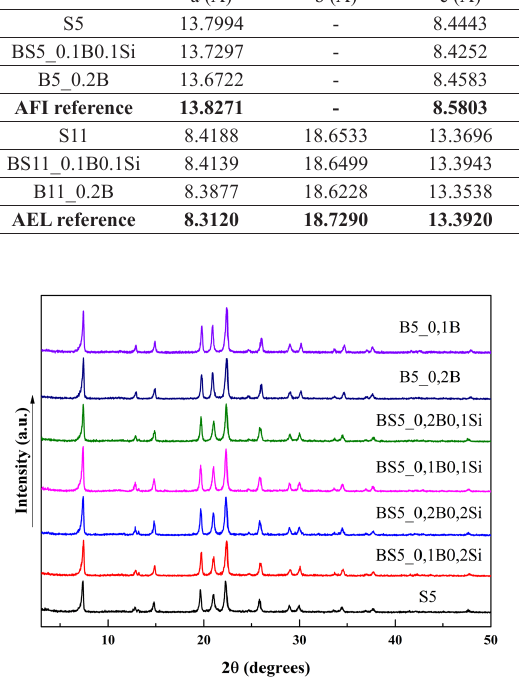
Figure 1. XRD profiles of samples synthesized with different compositions of the AFI